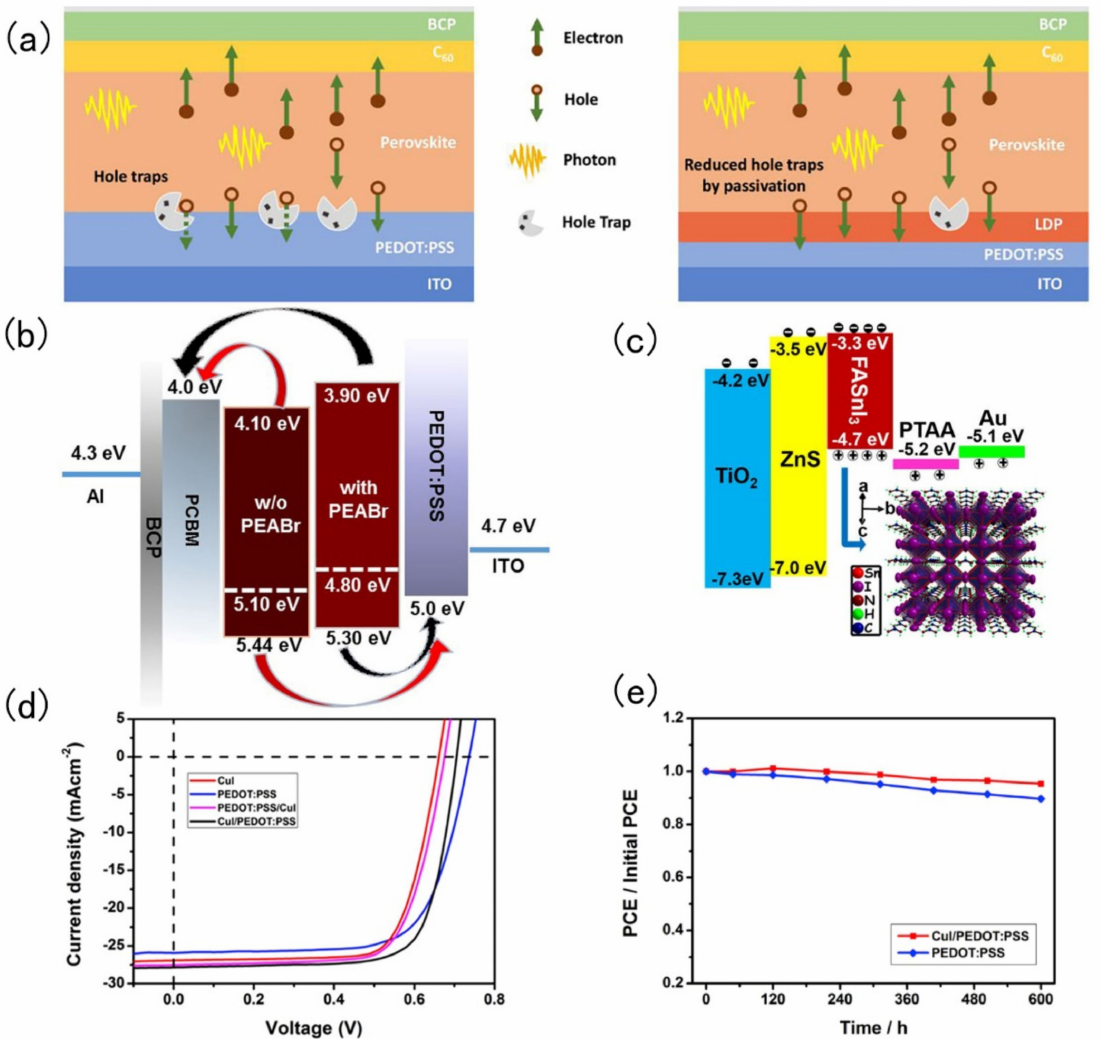
Figure 4. ( a ) Schematic of the trap states reduction by LDP passivation. Reproduced with permission from [64]. Copyright 2018 Elsevier Inc. ( b ) Energy level diagram of the inverted planar PSCs containing FASnI 3 without and with PEABr treatment. Reproduced with permission from [65]. Copyright 2019 Wiley-VCH Verlag GmbH & Co. KGaA, Weinheim. ( c ) The energy band diagram of the FASnI 3 solar cells and crystal structure of the perovskite absorber.